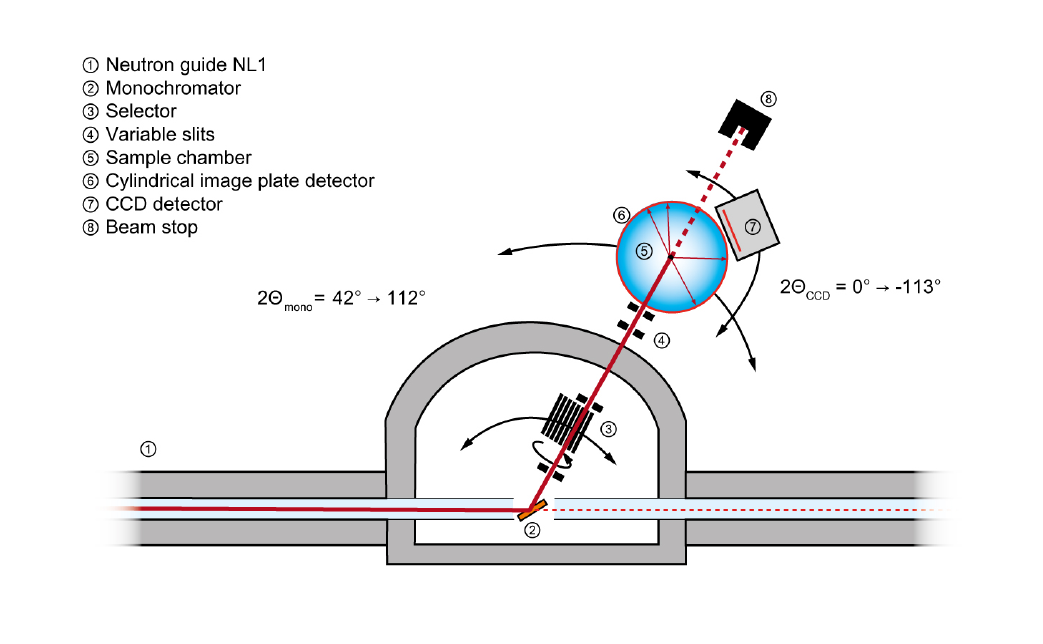
Figure 2: Schematic drawing of